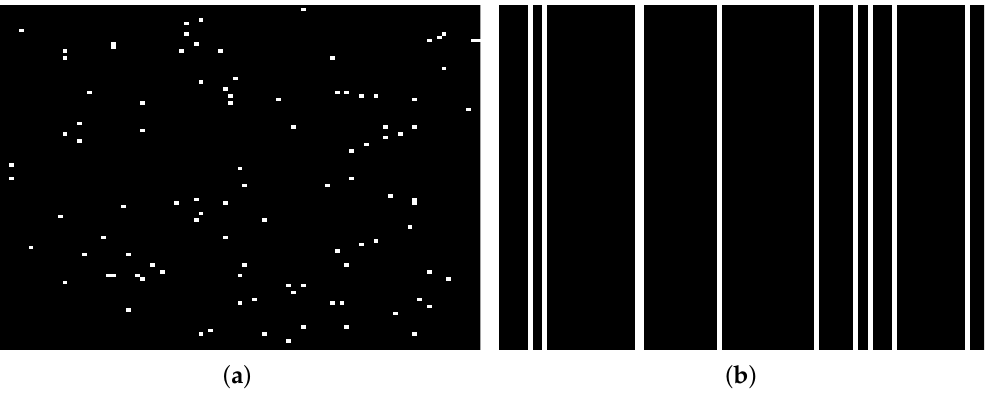
Figure 3. Error terms of two kinds of gross corruptions: ( a ) Random sparse corruptions. ( b ) image-specific